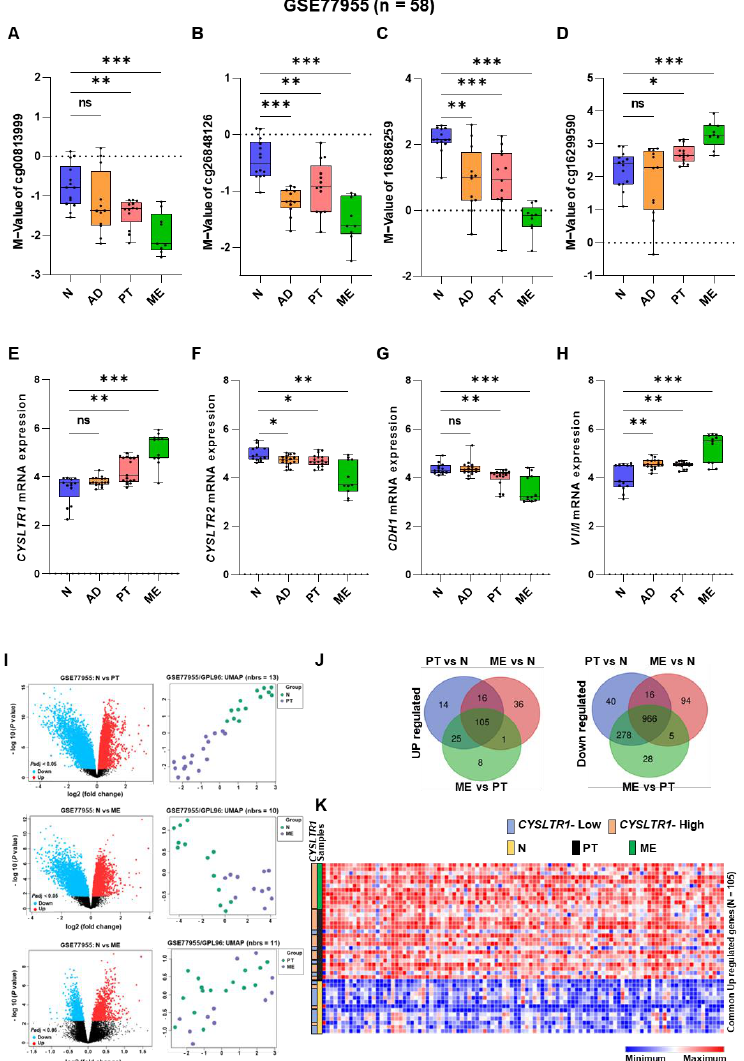
Figure 4. M-value distribution for the CpG probes of the CYSLTR1 and CYSLTR2 genes and their expression in matched normal (N), adenoma (AD), primary tumor (PT) and distant metastasis (ME) samples in the GSE77955 CRC cohort. ( A – D ) M-value distribution for the CpG probes in the N, AD, PT and ME samples. Relative expression of CYSLTR1 ( E ) and CYSLTR2 ( F ) genes between the N, AD, PT and ME samples. Relative expression of CDH1 ( G ) and VIM ( H ) genes between the N, AD, PT and ME samples. ( I ) Volcano plots and UMAP plots for the differentially expressed genes (DEGs) between PT vs. N, ME vs. N and ME vs. PT samples. ( J ) Venn diagram for the up-and downregulated genes from the DEGs between PT vs. N, ME vs. N and ME vs. PT samples. ( K ) Heatmap for the commonly upregulated gene expression in N, PT and ME samples. * p < 0.05; ** p < 0.01; *** p <